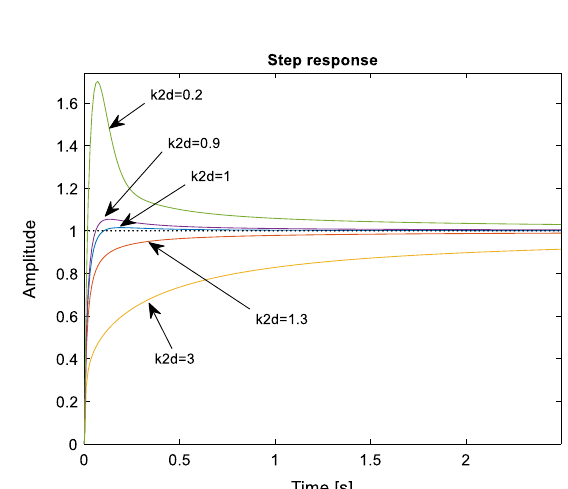
Fig. 38 Step response of the RSC control circuit using FFOADRC (for k 1d 1, α 0.7, ω c 10, and different k 2d = = =